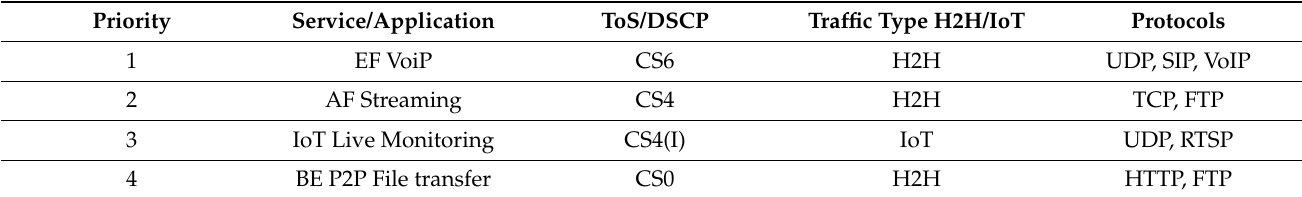
Table 2. H2H/IoT Service and Applications